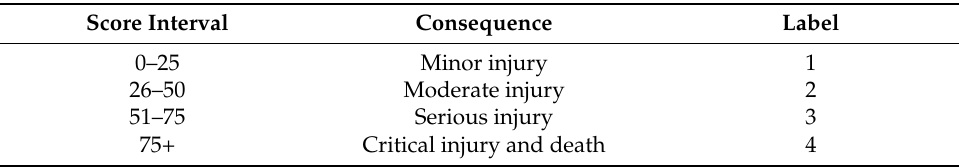
Figure 3. Standard severity score for different complications. Table 2. Description of the score